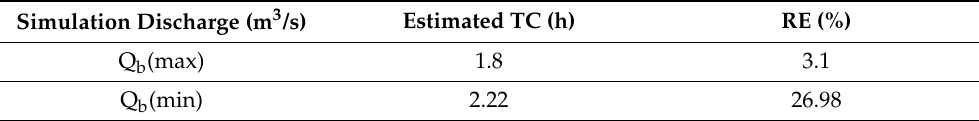
Table 12. TC (h) and RE (%) for Two-Dimensional